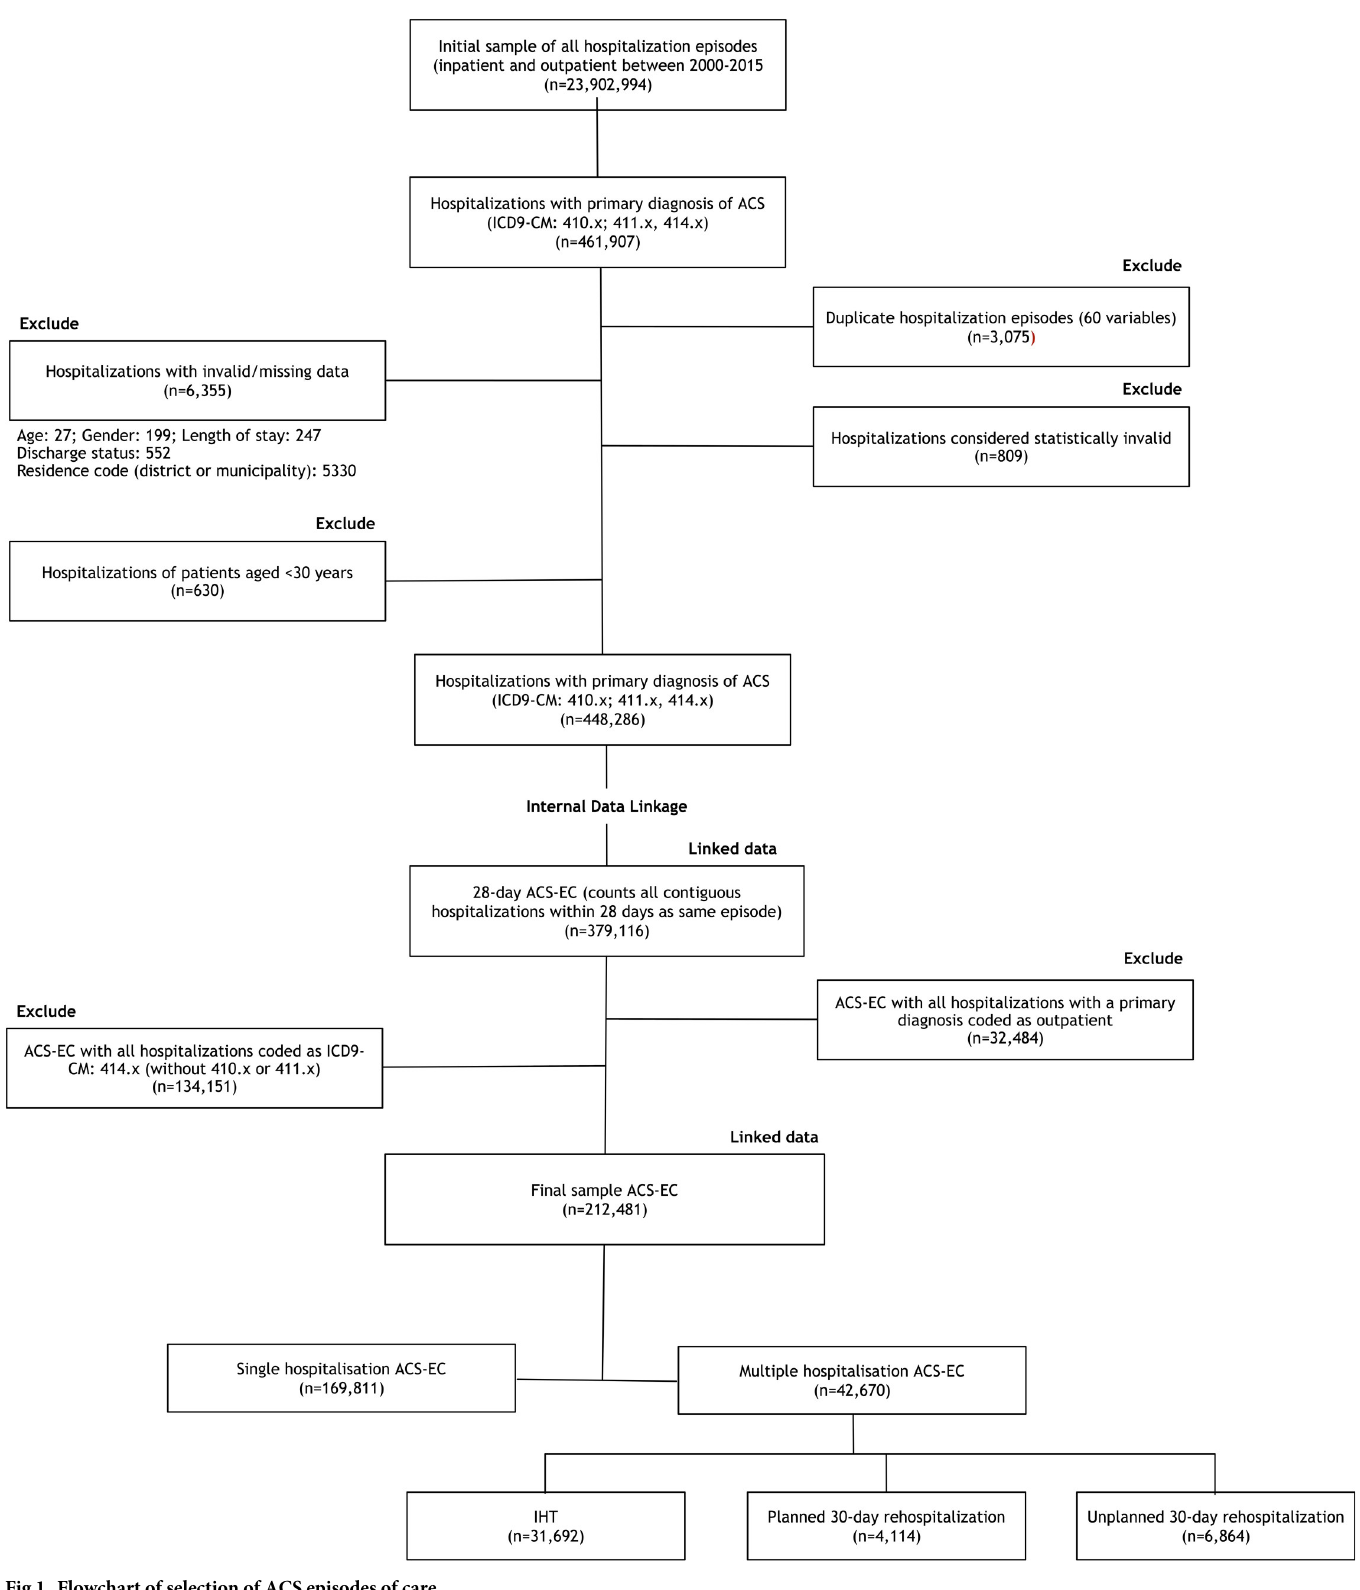
Fig 1. Flowchart of selection of ACS episodes of care.